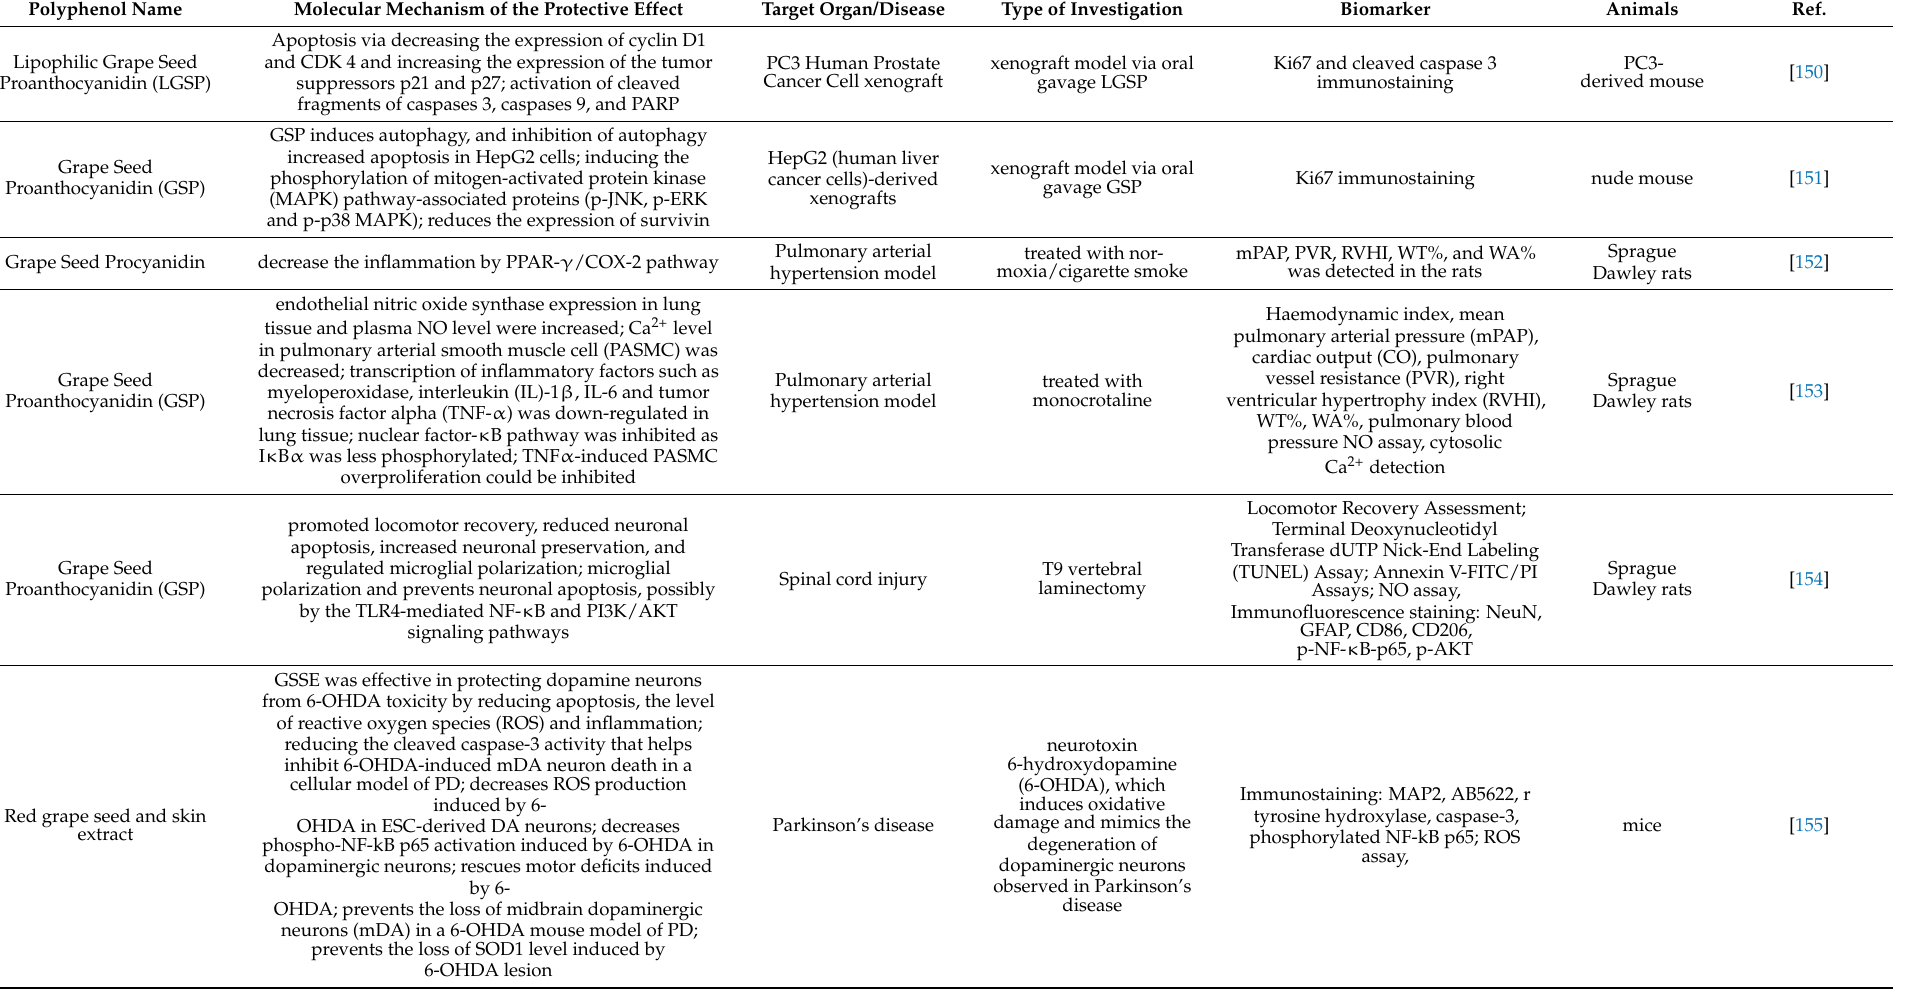
Table 15. In vivo experiments for investigations of healing effects of grape seed extract and its components in different